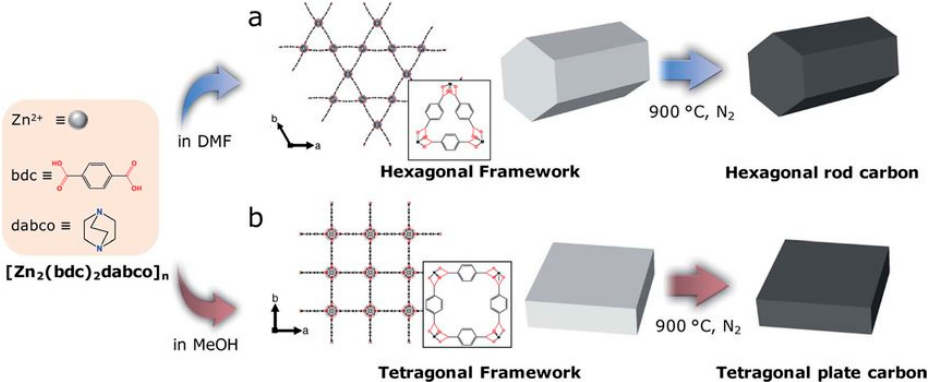
Figure 11. Solvent mediated synthesis of (Zn 2 (BDC) 2 (DABCO))n (ZBD) with controlled size, morphology, and polymorphism. ( a ) ZBD with a hexagonal framework (ZBDh), ( b ) ZBD with a tetragonal framework (ZBDt), and their transformation into nanoporous carbon. Reproduced by permission of Royal Society of